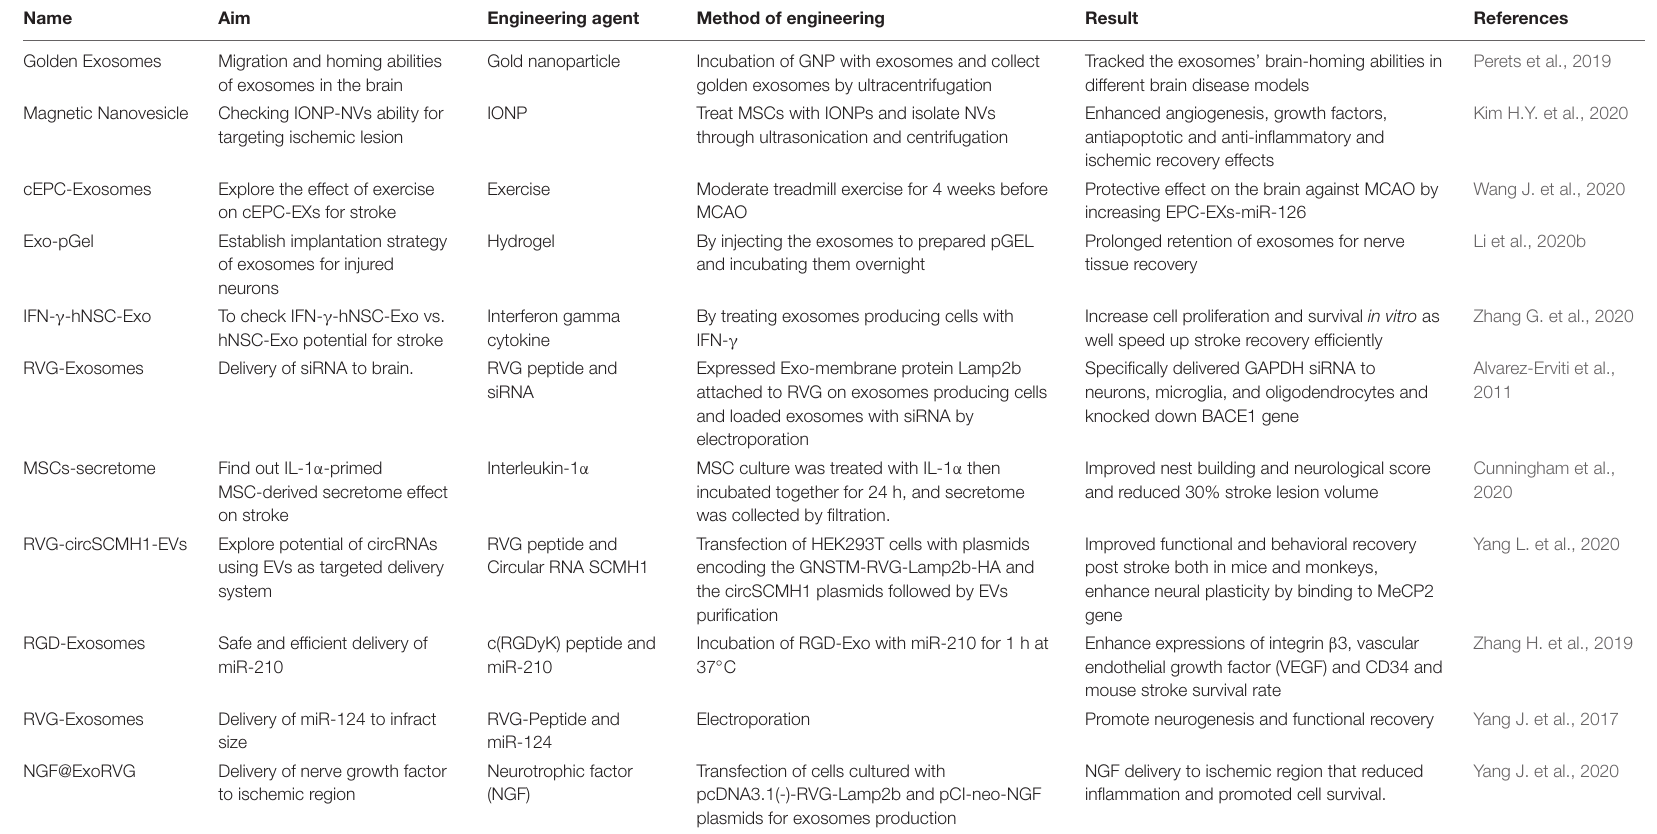
TABLE 2 | BioEng-Exo for